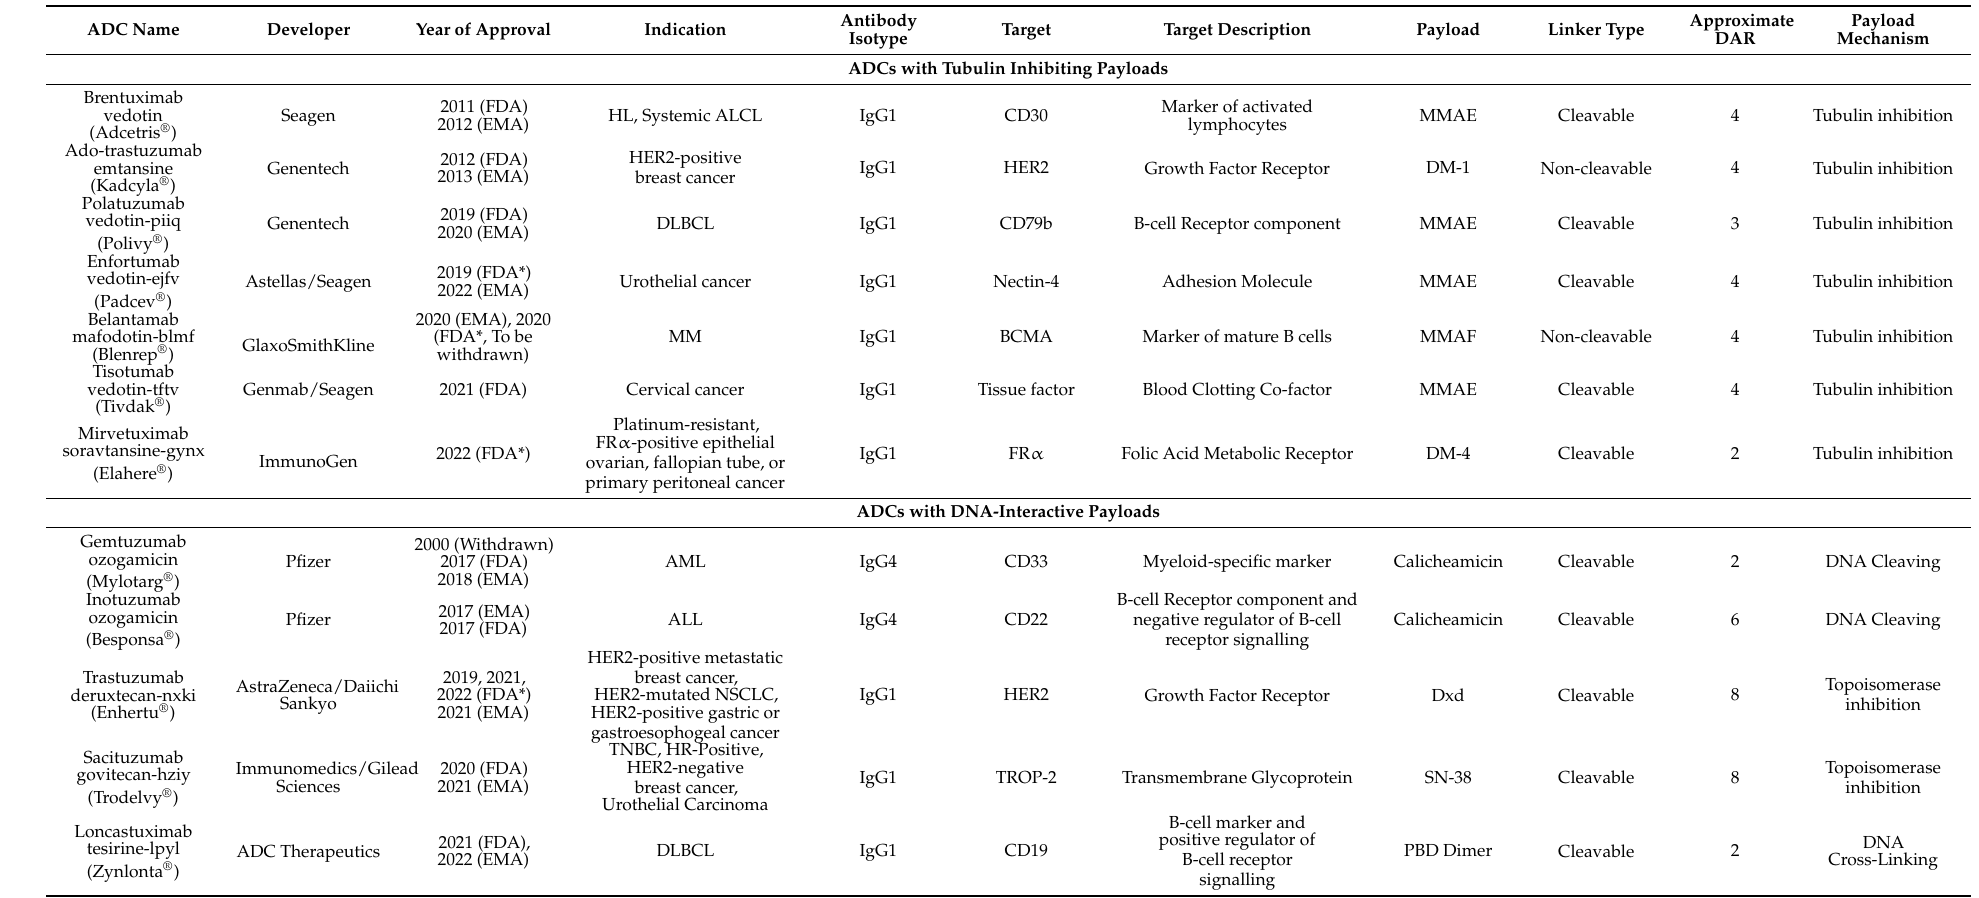
Table 1. Approved ADCs for the Treatment of Solid Tumours and Haematological